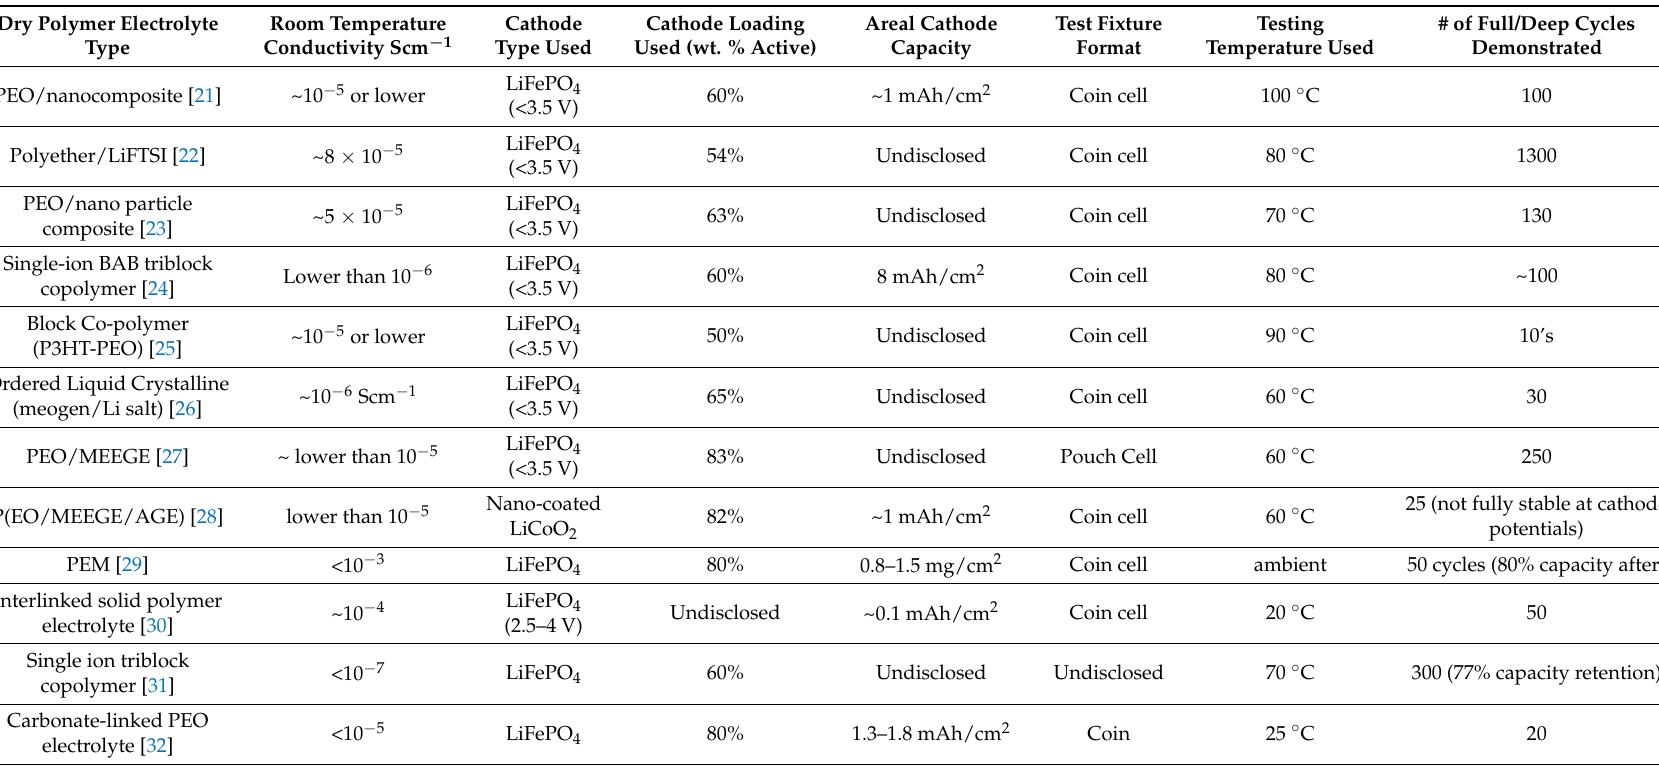
Table 1. Recent cell-level results reported from cells with dry solid polymer electrolytes. (Courtesy of Prof. Jay Whitacre, Carnegie Mellon